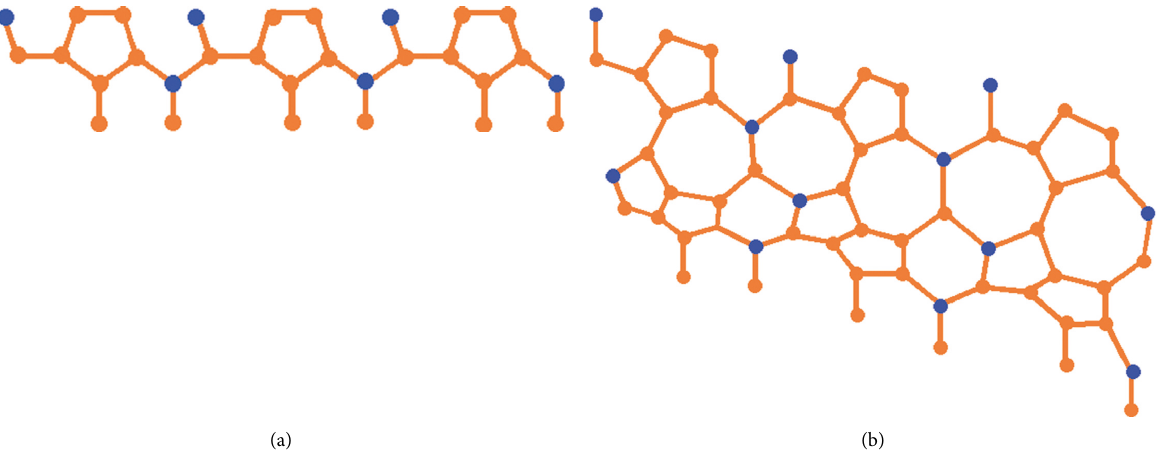
− I [ 3 , 3 ] , forr � 3 , s � 3. 3